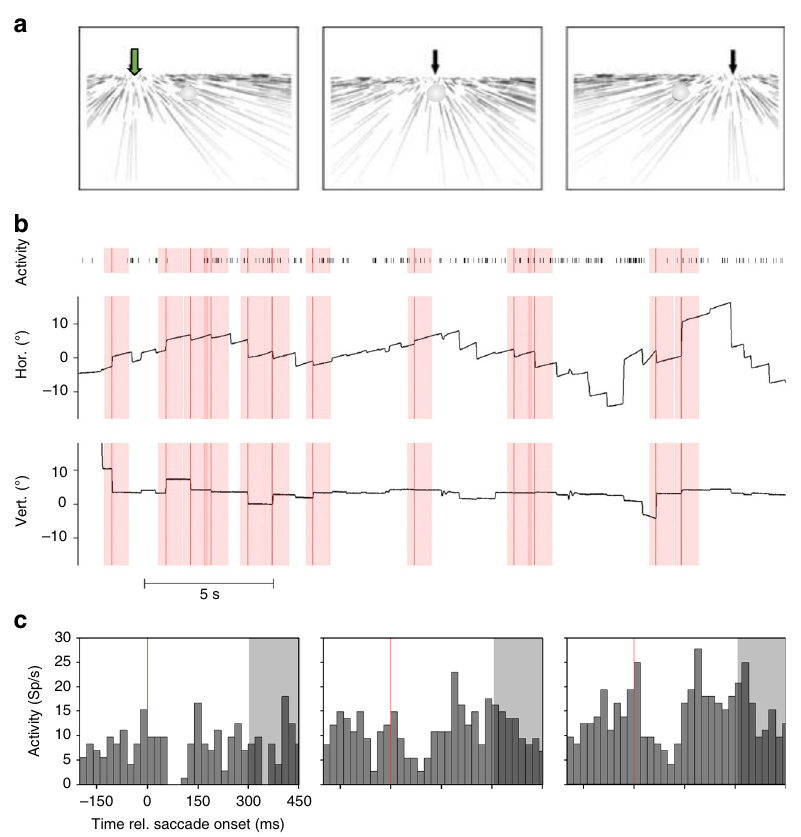
Fig. 1 Stimuli, eye movements, and neural responses. a Panels show schematically the optic- fl ow stimuli presented to the monkeys. In pseudorandomized order, stimuli simulated self-motion across a ground plane to the left, straight ahead or to the right. Without additional eye movements, heading direction is given by the singularity of the optic fl ow fi eld 15, 22, 23, 57 , as indicated by the tip of the arrow in each panel. b The panels show spontaneous horizontal and vertical eye movements as well as activity of an MST neuron for an exemplary trial of self-motion to the left (also indicated by the green arrow in a . Re fl ex- like slow eye movements mainly to the right were accompanied by saccades in the opposite direction. We determined the onset of saccades, as indicated by the vertical red lines in the neural and eye-movement data. In order to determine a neuron ’ s tuning for self-motion direction, we split the long-trial data into 650 ms long snippets, positioned around the onset of each saccade. Our selection criterion for such snippets required that for a given saccade no further saccade must occur from 200 ms before this saccade until 450 ms thereafter. The temporal snippets that met this criterion are marked with red, transparent vertical rectangles in the neural and eye-movement data. c The resulting perisaccadic responses of the same neuron, whose discharges are shown in b , are shown for all three self-motion directions. This neuron was signi fi cantly tuned for rightward self-motion (ANOVA on ranks, 2 df, P < 0.05). We used a brief, 150 ms post-saccadic interval (300 – 450 ms, indicated by the gray shaded areas in the response histograms) of each neuron ’ s response to the three simulated headings to compute the linear regression parameters. For this neuron, the linear regression function y ( t ) = 0.108 (Sp/s)/ º * x + 11.77 Sp/s; r 2 = 0.997, P < 0.05, fi tted the data signi fi